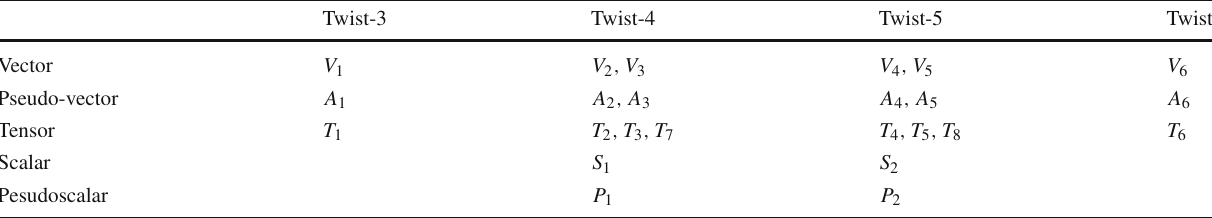
Table 1 Twist classification of the proton LCDAs in Eq. (16) Twist-3 Twist-4 Twist-5 Twist-6 Vector V 1 V 2 , V 3 V 4 , V 5 V 6 Pseudo-vector A 1 A 2 , A 3 A 4 , A 5 A 6 Tensor T